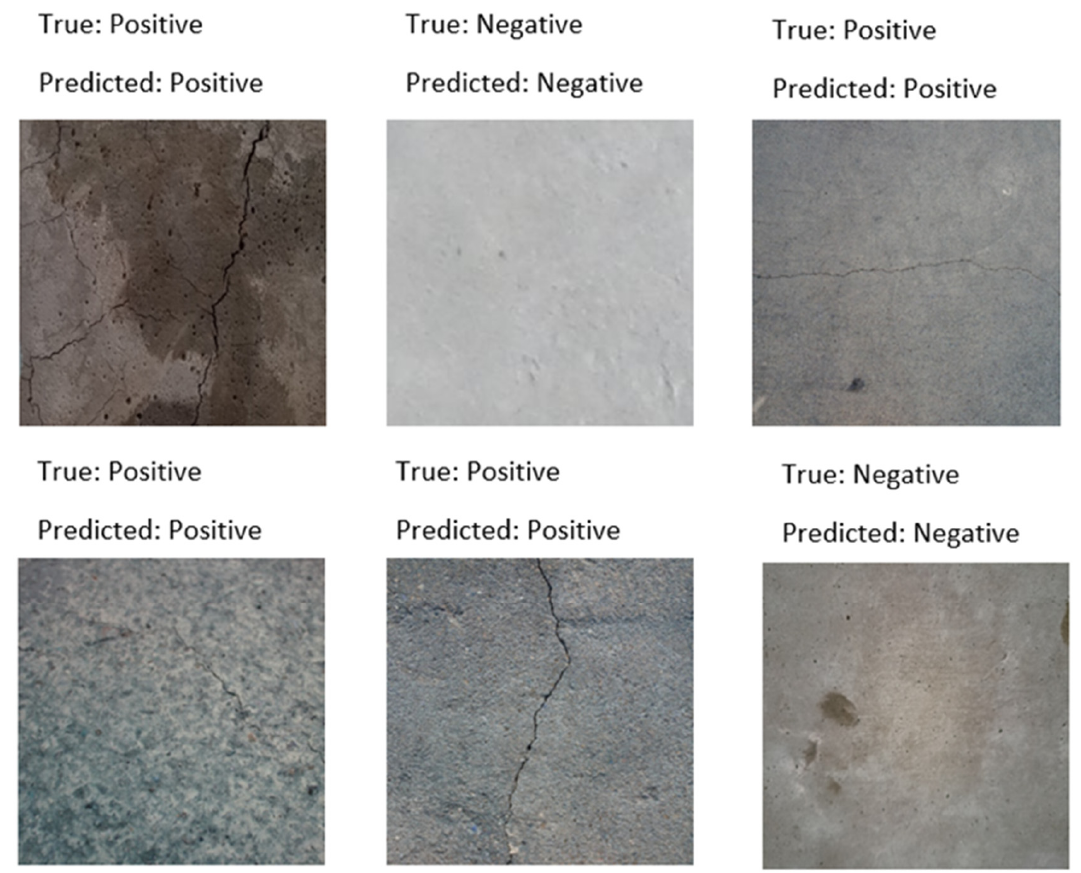
Figure 9. Sample classification result on test images by the VGG16 architecture.